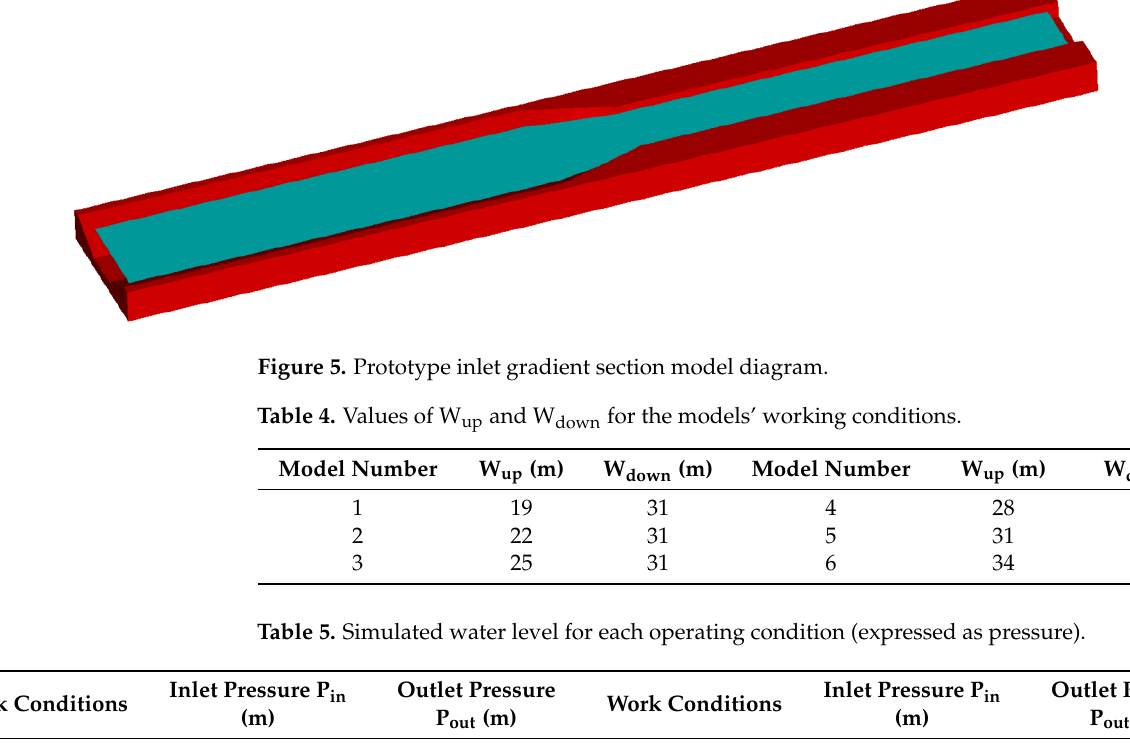
Table 5. Simulated water level for each operating condition (expressed as pressure).